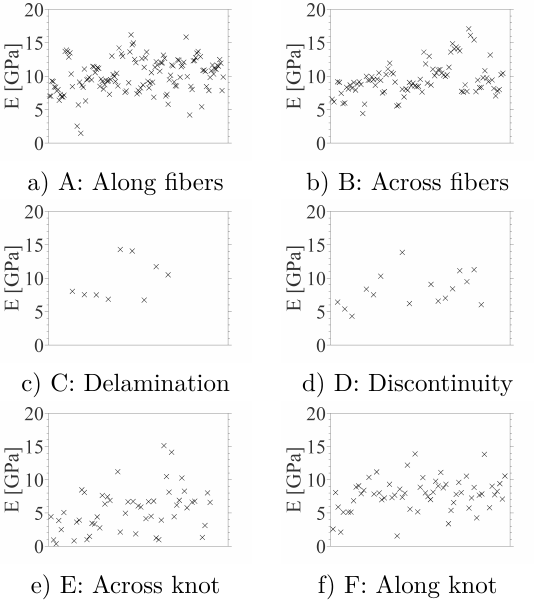
Table 2. Young’s moduli from tensile test in [GPa] depending on the level of browning.